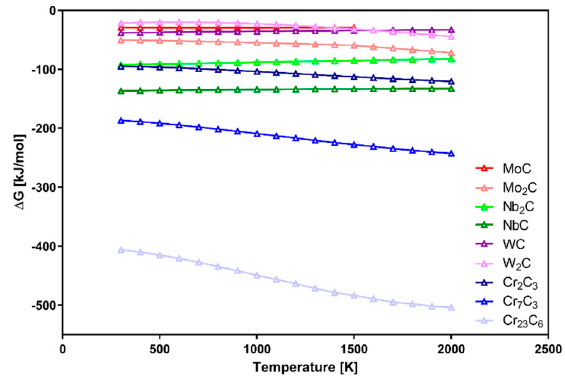
Figure 1. Gibbs free energy for simple carbides that can form in Inconel 625–WC system [16–26].